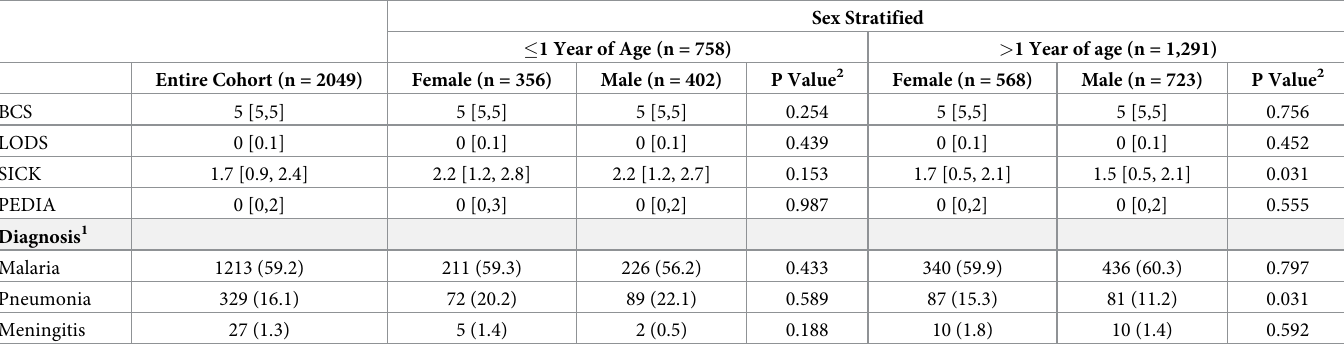
Table 2. Disease severity at presentation and diagnosis by